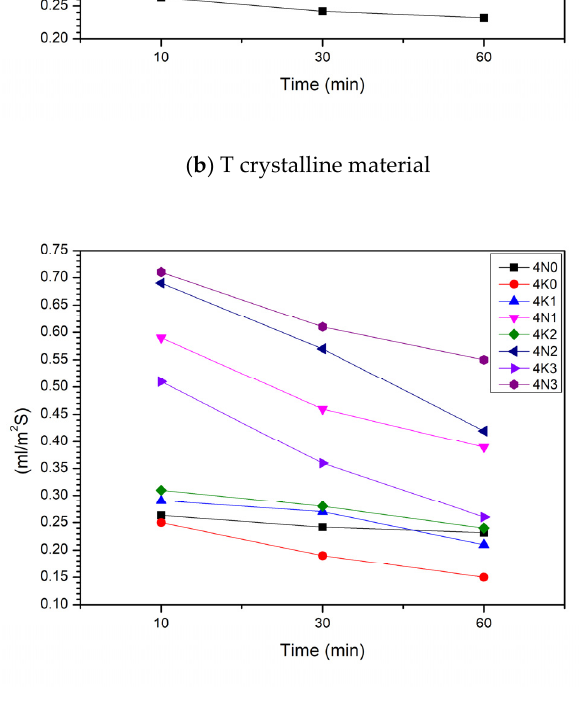
Figure 11. Initial surface water absorption of cement mortar after 56 days when W/C = 0.6.